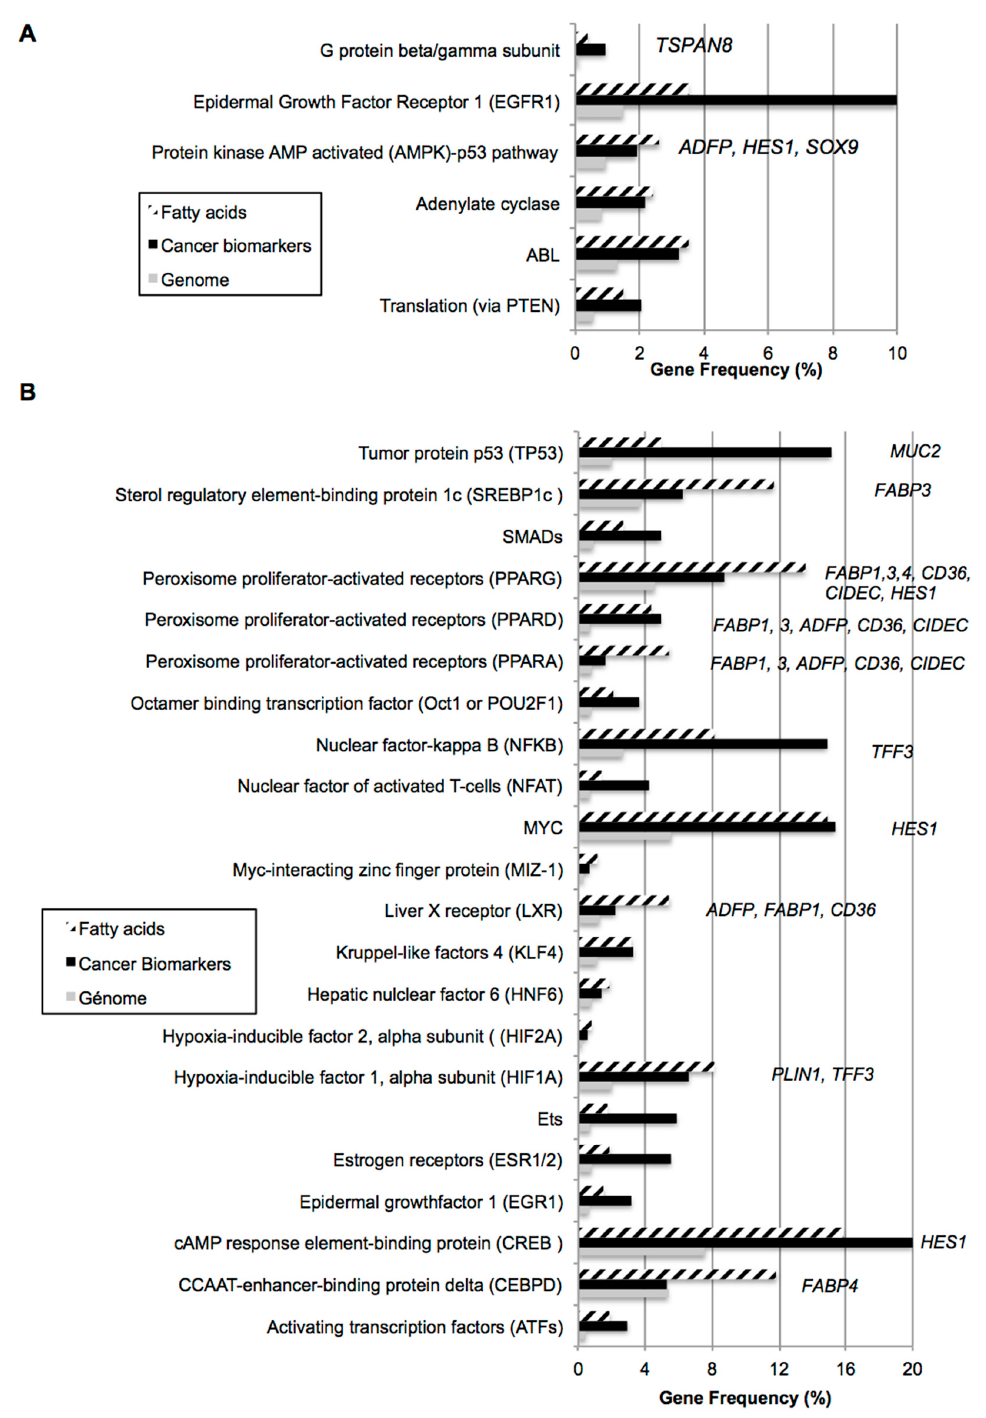
Figure 2. Fatty acids-linked signaling pathways related to cancer. Fatty acids gene datasets were compared to 48 gene datasets related to intracellular pathways ( A ) and 52 gene datasets related to transcription factors ( B ). Only significantly over-represented pathways in both fatty acids and cancer biomarkers datasets are represented (Z-score confidence level >90% versus genome). Target genes further analyzed by qRT-PCR are reported in italic characters.